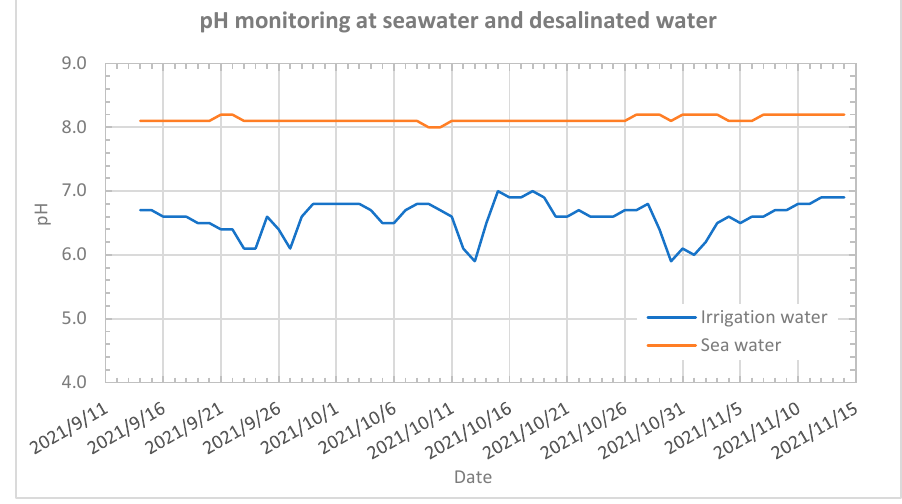
Figure 17. pH monitoring.